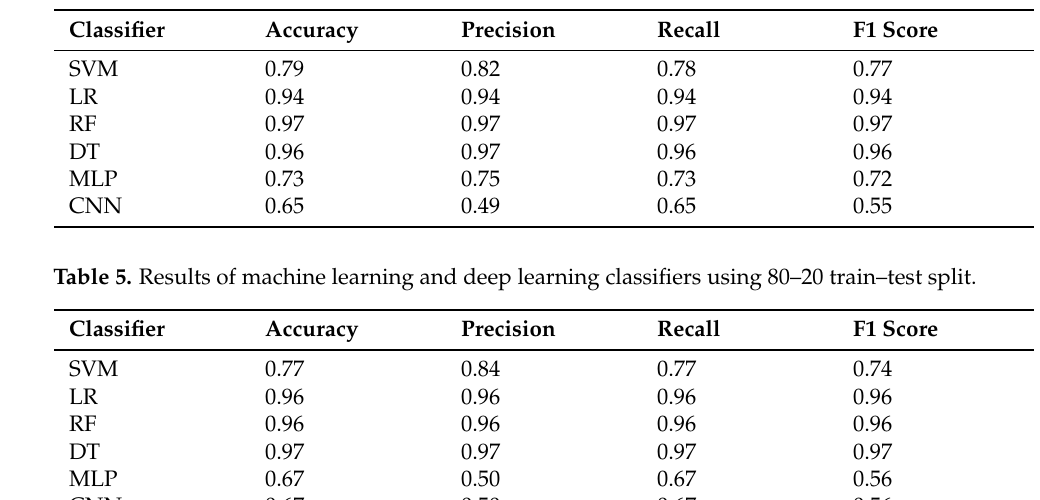
Table 4. Results of machine learning and deep learning classifiers using 70–30 train-test split.